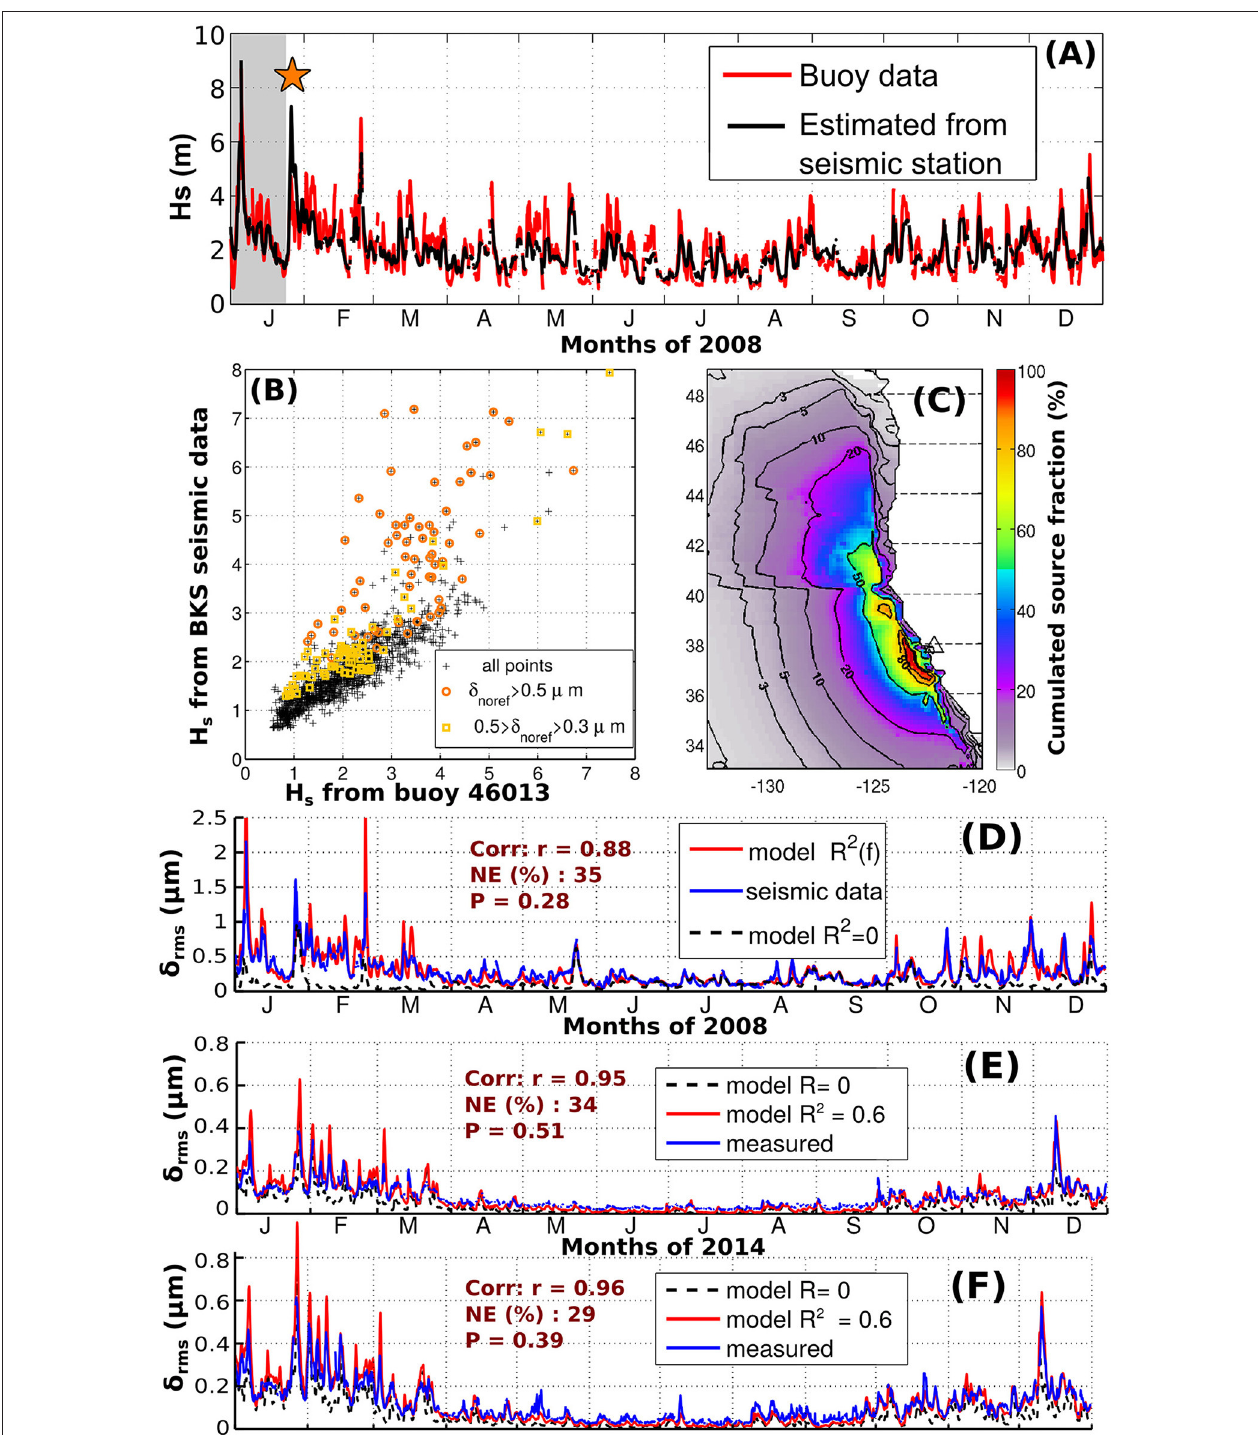
FIGURE 11 | (A) Measured wave heights at buoy 46013 and estimates from the BKS seismic station. The star marks a particular event on January 26 with microseisms generated by oposing wave trains from two distinct storms. (B) Correlation between measured and estimated wave heights, highlighting the outliers unrelated to coastal reflections (C) Average spatial distribution of microseism sources recorded at the BKS seismic station (triangle). (D–F) : modeled and measured microseism amplitude at stations BKS, station 4 of the Grafenberg array (Germany), and Uccle (Belgium). Model results are shown with or without coastal reflection to give a sense of the uncertainty of the simulation and of the importance of the wave energy reflection coefficient, which is set here at 6, 12, and 24% for continents and large islands, islands smaller than 50 km, and icebergs, respectively.